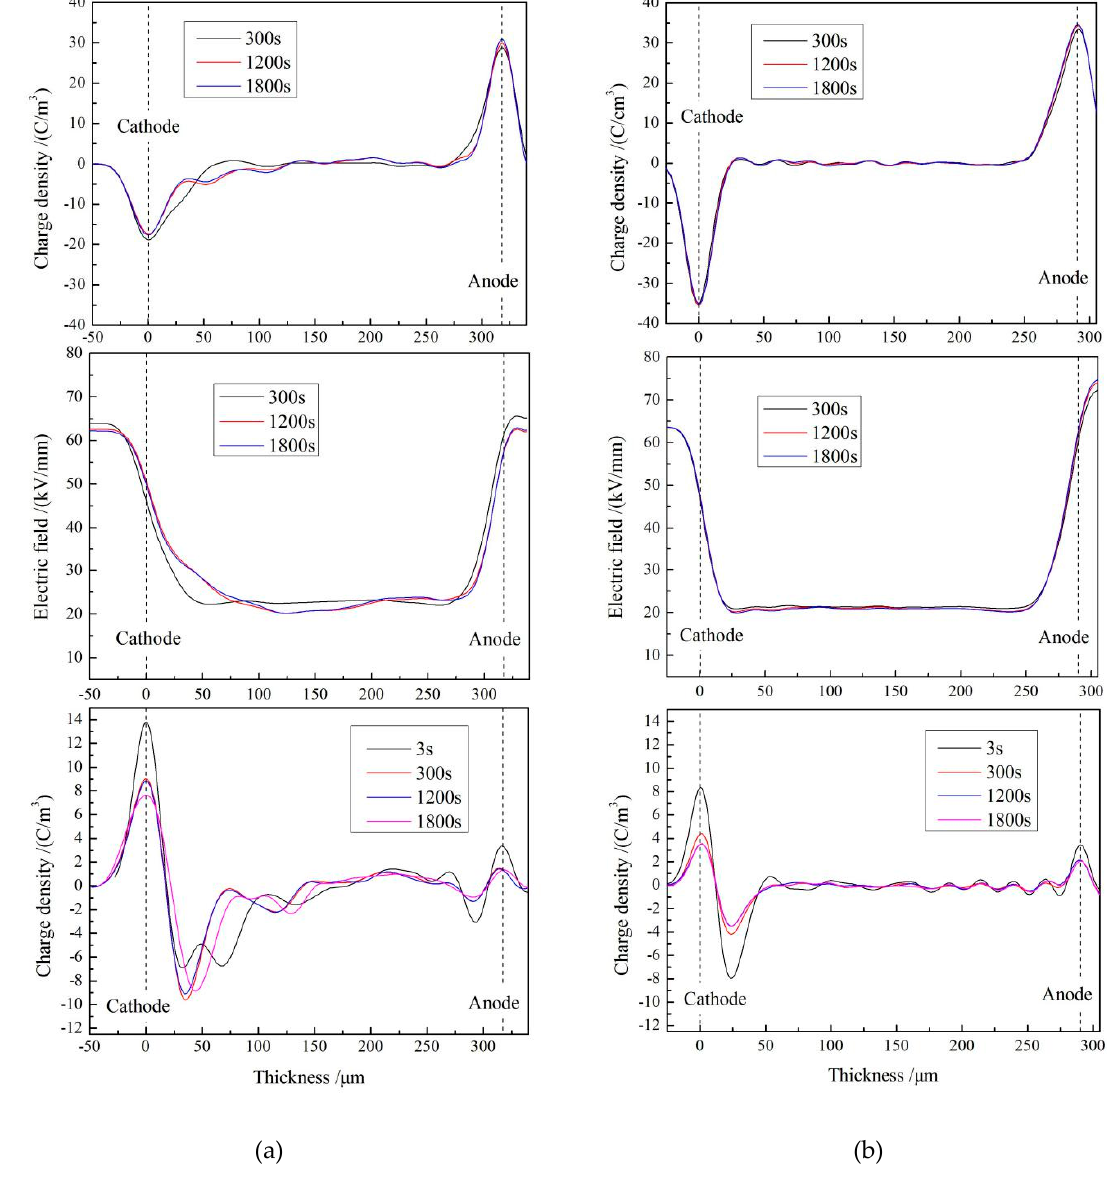
Figure 3. Space-charge distributions at 25 °C in ( a ) LLDPE, ( b ) UV-XLPE-TMPTMA under applied DC electric field 40 kV / mm (upper panels) and in short circuit (bottom panels). The electric field distributions across samples in polarization process are illustrated in middle panels.